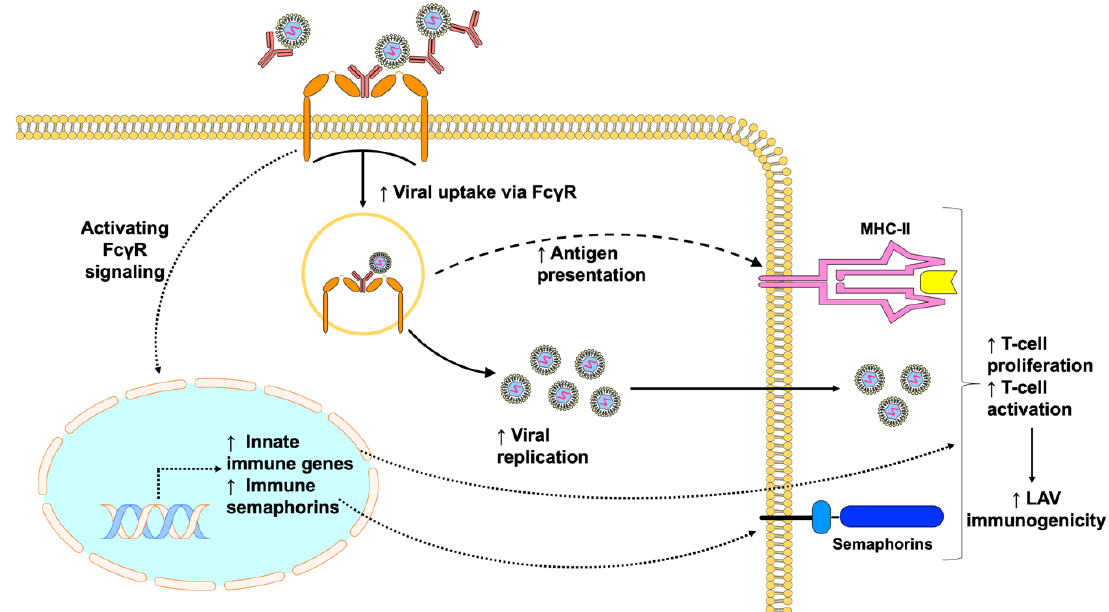
Figure 3. Pre-existing antibodies can improve vaccine immunogenicity by promoting virus infection and inducing innate and adaptive immune responses. Immune complexes formed by pre-existing antibodies and viruses can engage Fc γ Rs, resulting in increased viral uptake and fusion through the process of antibody-dependent enhancement that leads to increased vaccine viremia and antigen presentation. Activating Fc γ R-signaling, on the other hand, provokes greater innate immune responses and production of pro-inflammatory metabolites that can enhance innate and adaptive immune responses. In addition, the cross-linking of Fc γ Rs causes increased expression of immune semaphorins, which are critical for antigen-presenting cell and T-cell interaction. Overall, this leads to increased T-cell proliferation and activation, which consequently improves LAV immunogenicity.